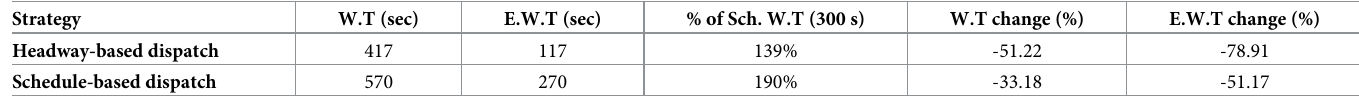
Table 10. Effect of terminal dispatch strategies on waiting time.